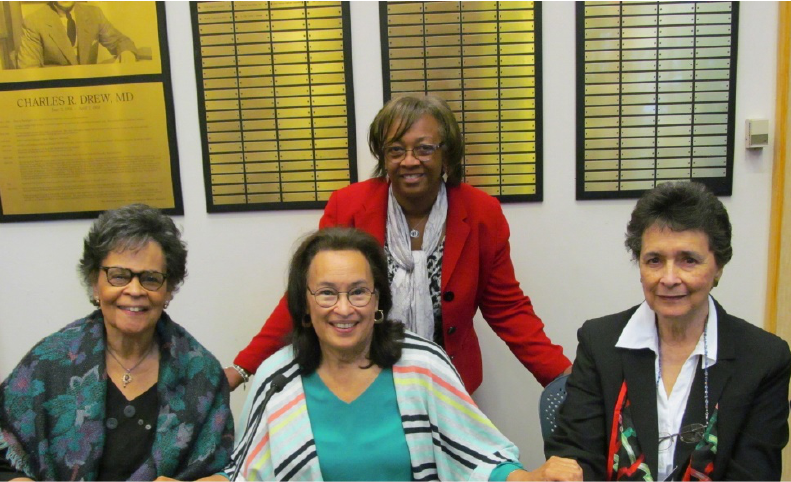
Figure 1 The Drew siblings: Charlene Drew Jarvis, Sylvia Drew Ivie, and Bebe Drew Price (sitting); Darlene Parker-Kelly, director, Health Sciences Library, Charles R. Drew University of Medicine and Science (CDU) (standing)